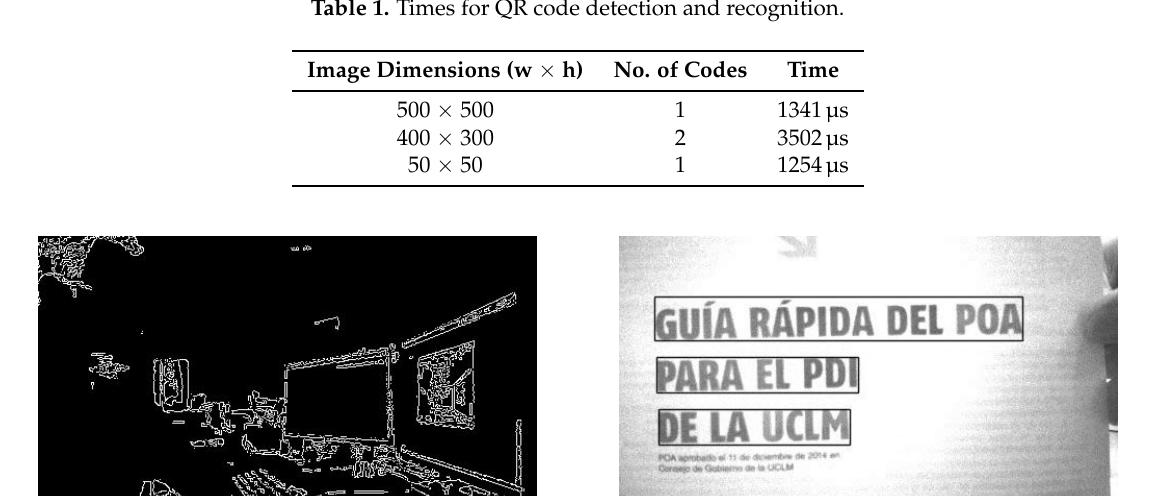
Table 1. Times for QR code detection and recognition.